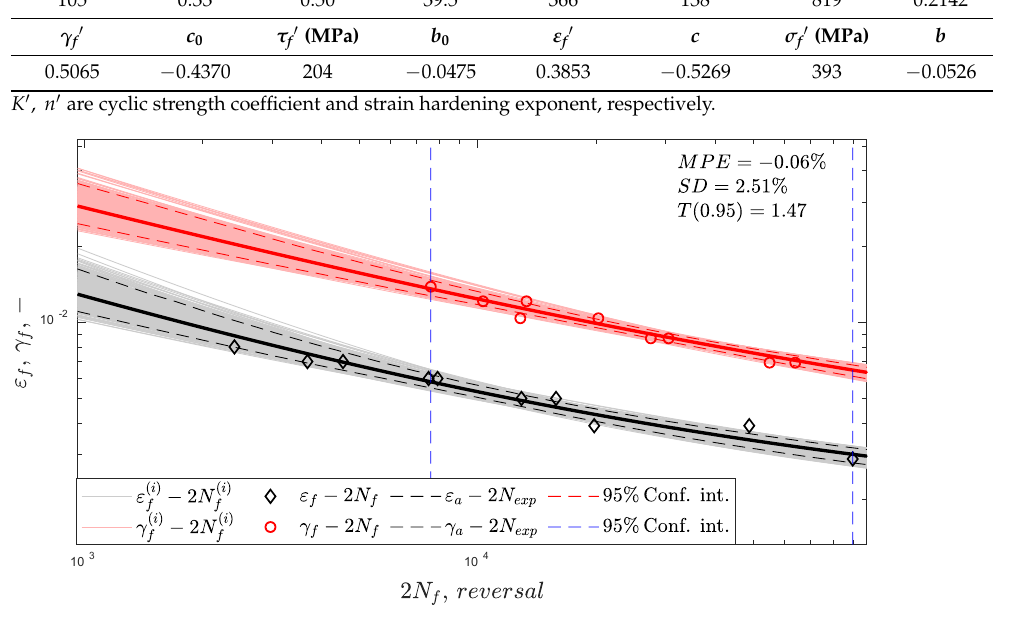
𝐵𝐵𝑃𝑃𝐸𝐸 , 𝐶𝐶𝑆𝑆 , 𝑇𝑇 (0.95)